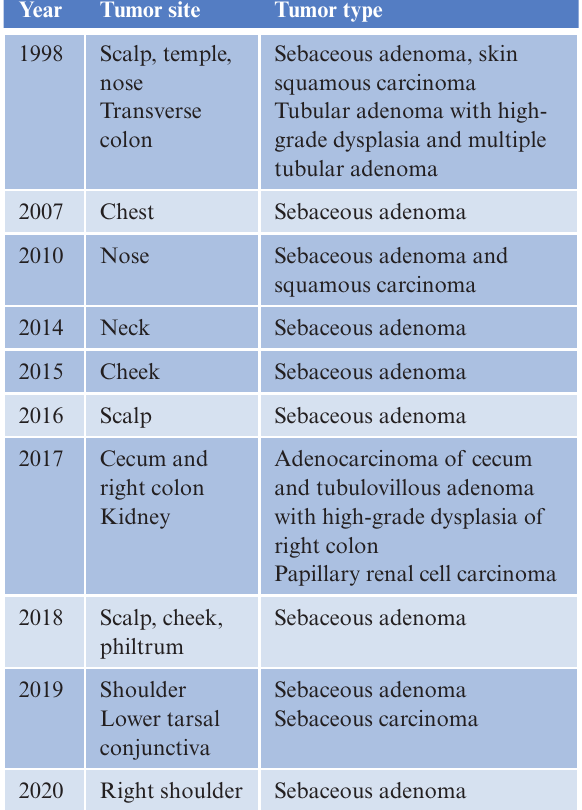
Table 1: List of neoplasms in this